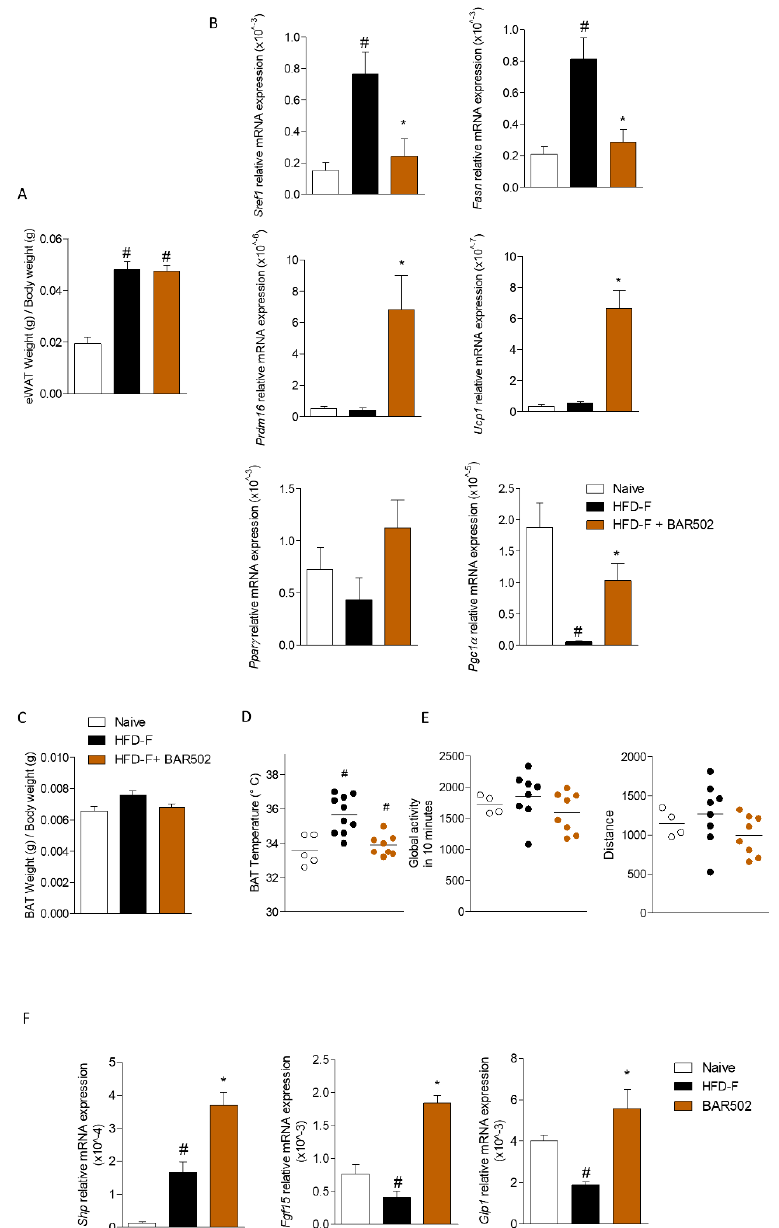
Figure 5. Effects of HFD – F on adipose tissue and ileum. BAR502, 20 mg/kg/day, was administered by gavage in C57BL/6J male mice starting on day 10 of HFD and fructose for additional 11 weeks. Panels A – B. Analysis of epididymal White Adipose Tissue (eWAT). ( A ) Ratio of eWAT weight to body weight. ( B ) Changes in mRNA expression of genes involved in: lipid synthesis and metabolism (Srebf1, Fasn), brite/beige trans-differentiation and β - oxidation (Prdm16, Ucp1, Pparγ, Pgc1α ). Panels C – E. Analysis of Brown Adipose Tissue (BAT). ( C ) Ratio of BAT weight to body weight. ( D ) Thermogenic activity of BAT as measured by infrared spectroscopy. ( E ) Physical activity of mice expressed as Global activity and distance. The data showed in panels D – E are recorded after 10 weeks of HFD – F. ( F ) Change in transcript levels of genes involved in regulation of intestinal metabolism (Shp, Fgf15, Glp1). The RT- PCR values were normalized against β2 -Microglobulin and Gapdh, and the relative mRNA is expressed according the Ct method as described in Materials and Methods. The data shown are mean ± SE M of 7 – 10 mice/group. In each panel # denotes p < 0.05 versus Naïve mice, * denotes p < 0.05 versus HFD – F mice.